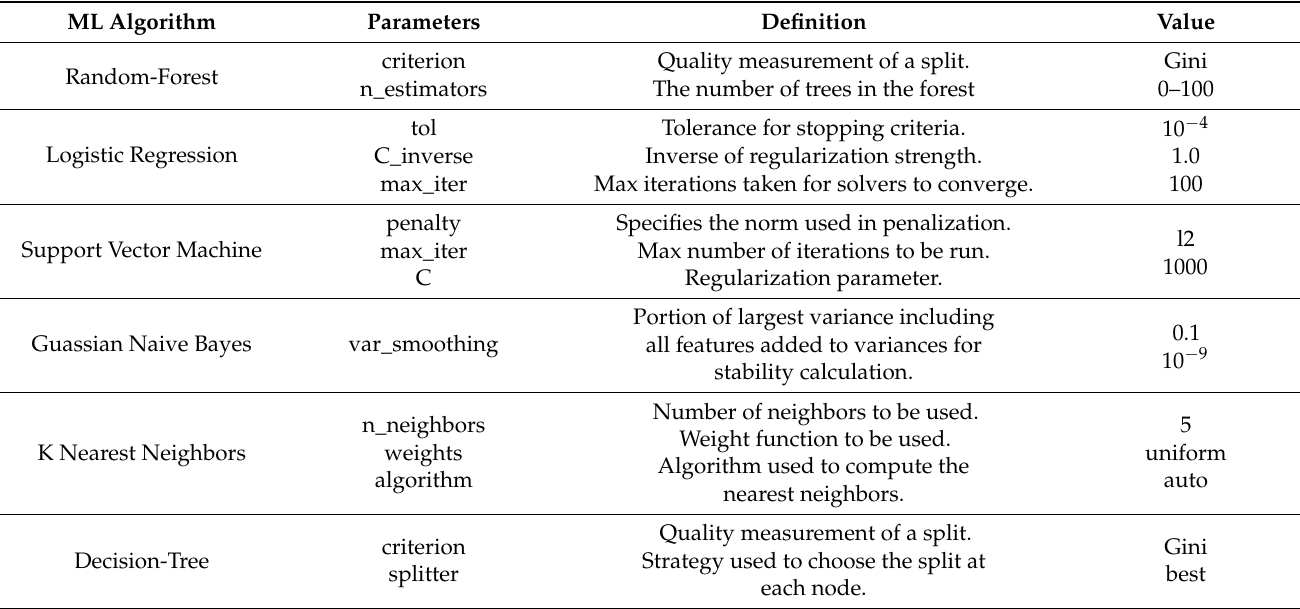
Table 6. Parameters tuned in the ML algorithms.